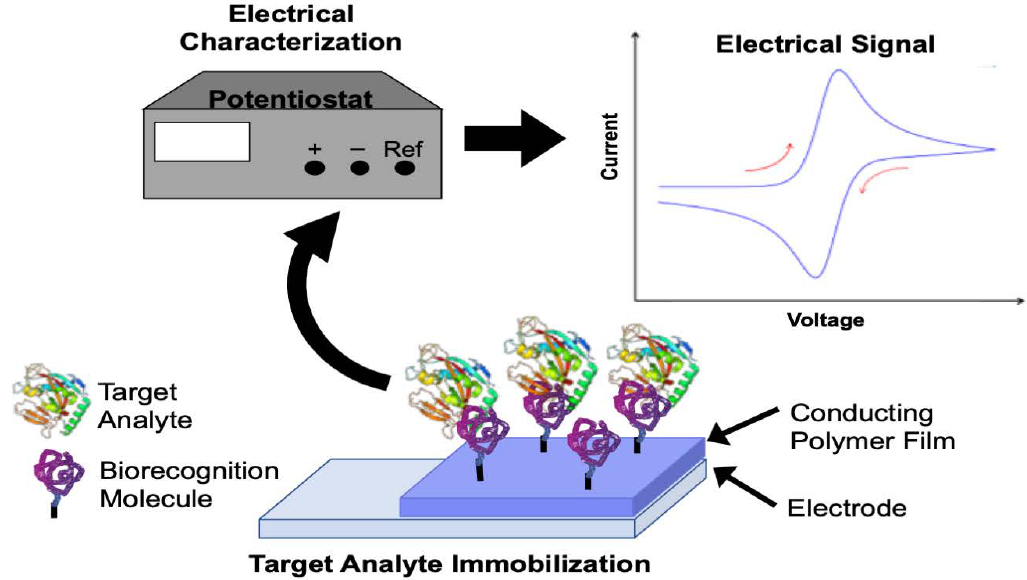
Figure 5. Electrochemical sensing